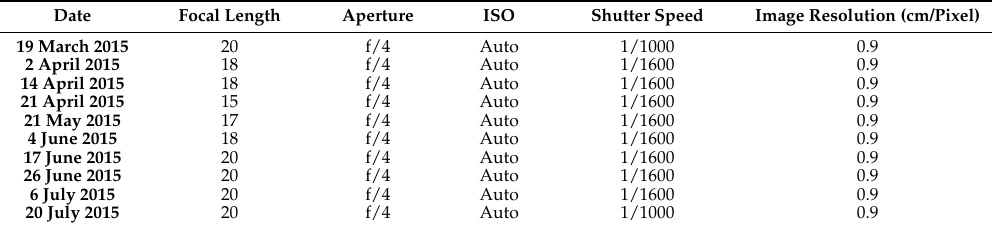
Table 7. Camera settings and image parameters for each flight used in the 2015